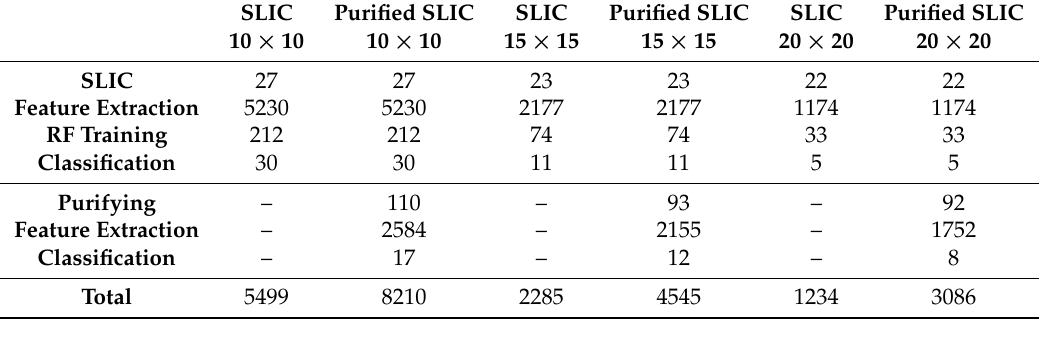
Table 4. Average time cost (s) for each step in ten runs of classification.